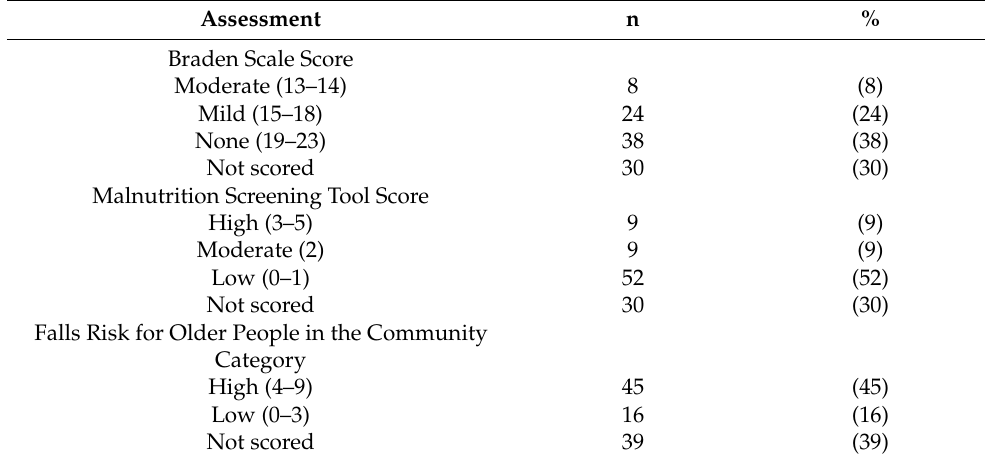
Table 2. ESOT assessments of clients’ risk of pressure injury, malnutrition, and falls (n =